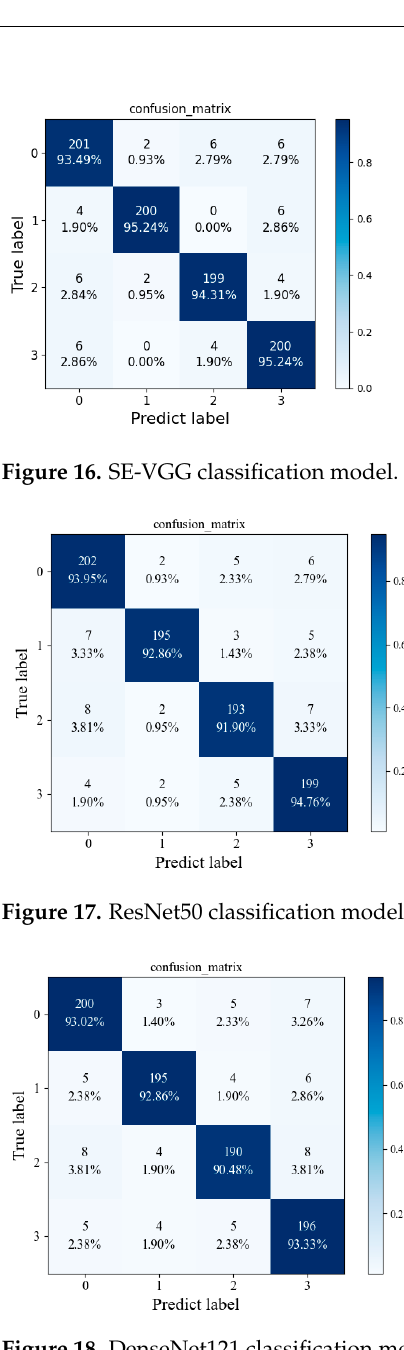
13 of 20 Figure 13. Alex classification model. Figure 14. VGG classification model.